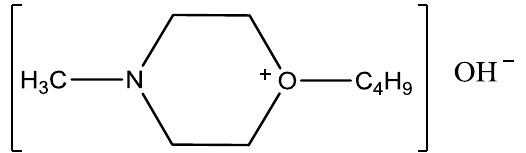
Figure 8. Chemical structure of alkaline ionic liquid